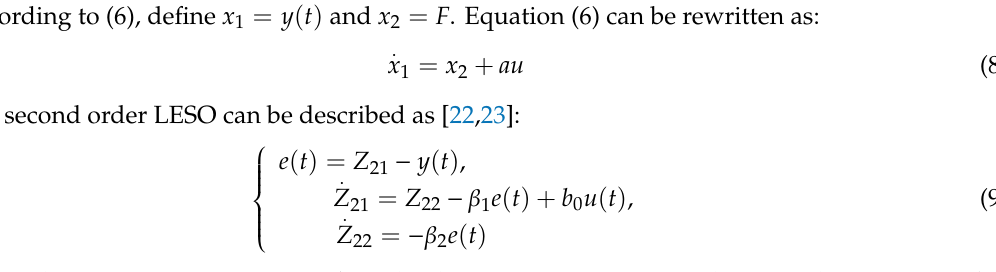
. Figure 1. The novel control block diagram using the proposed MFiPISTSMC strategy with i d ( t ) = d